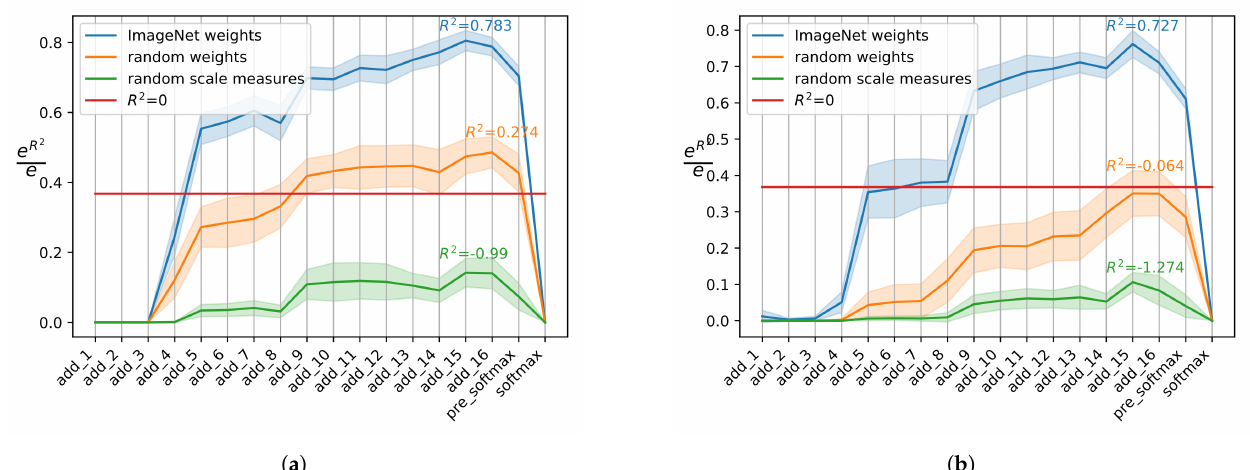
Figure A1. Comparison of regression (RCV) of scale measures at different ResNet50 layers on the classes: ( a ) race car (ID: n04037443), ( b ) kite (ID: n01608432). The regression is evaluated as e R